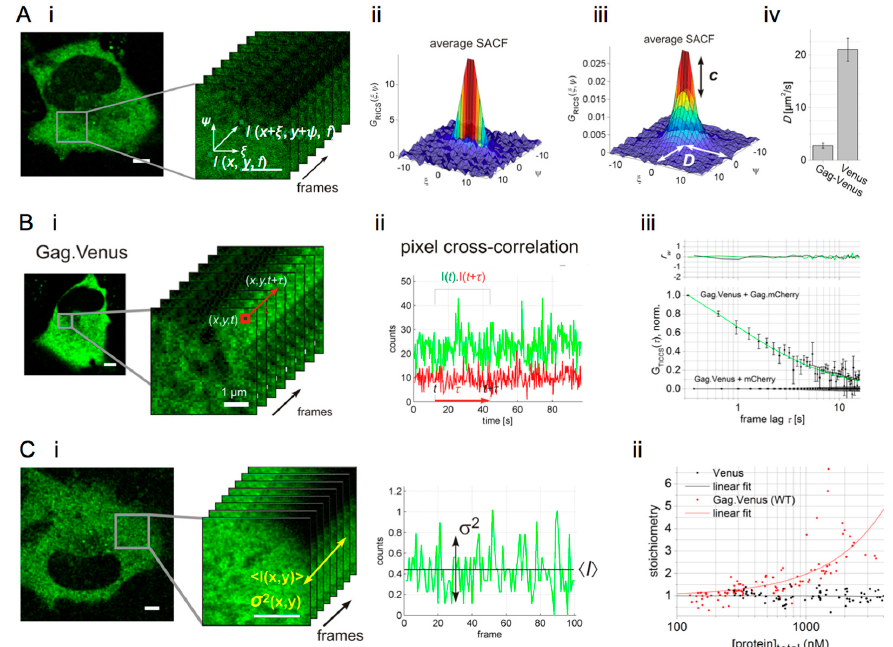
Figure 4. ( A ) ( i ) A confocal image of cytosolic Gag tagged with the Venus fluorescent protein (FP). Spatial correlation of an area of the image is performed via raster image correlation spectroscopy (RICS) analysis, where multiple scanned frames are used to obtain an average spatial correlation; ( ii ) average spatial autocorrelation function (SACF) of fast diffusing molecules, here cytosolic Venus FP; ( iii ) average SACF of slowly diffusing molecules and a fit to the SACF model provide concentration ( c ) and diffusion coefficient ( D ) of the molecules. Here, Gag.Venus data is shown; ( iv ) D of cytosolic Gag.Venus versus free cytosolic Venus determined from the RICS analysis. ( B ) ( i ) Confocal image series and temporal correlation via TICS of a pixel signal in the series; ( ii ) Exemplary temporal cross-correlation of dual-color signals determined via TICCS analysis; ( iii ) TICCS analysis of the co-expressed Gag.Venus and Gag.mCherry and the corresponding negative control (Gag.Venus+mCherry). r w is the weighted residual of the fit. ( C ) ( i ) Intensity map of cytosolic Gag.FP, illustrating the mean intensity and variance of the signal in a single pixel; ( ii ) mean stoichiometry of diffusing cytosolic molecules as a function of their concentration. ©Hendrix et al., 2015. Originally published in JOURNAL OF CELL